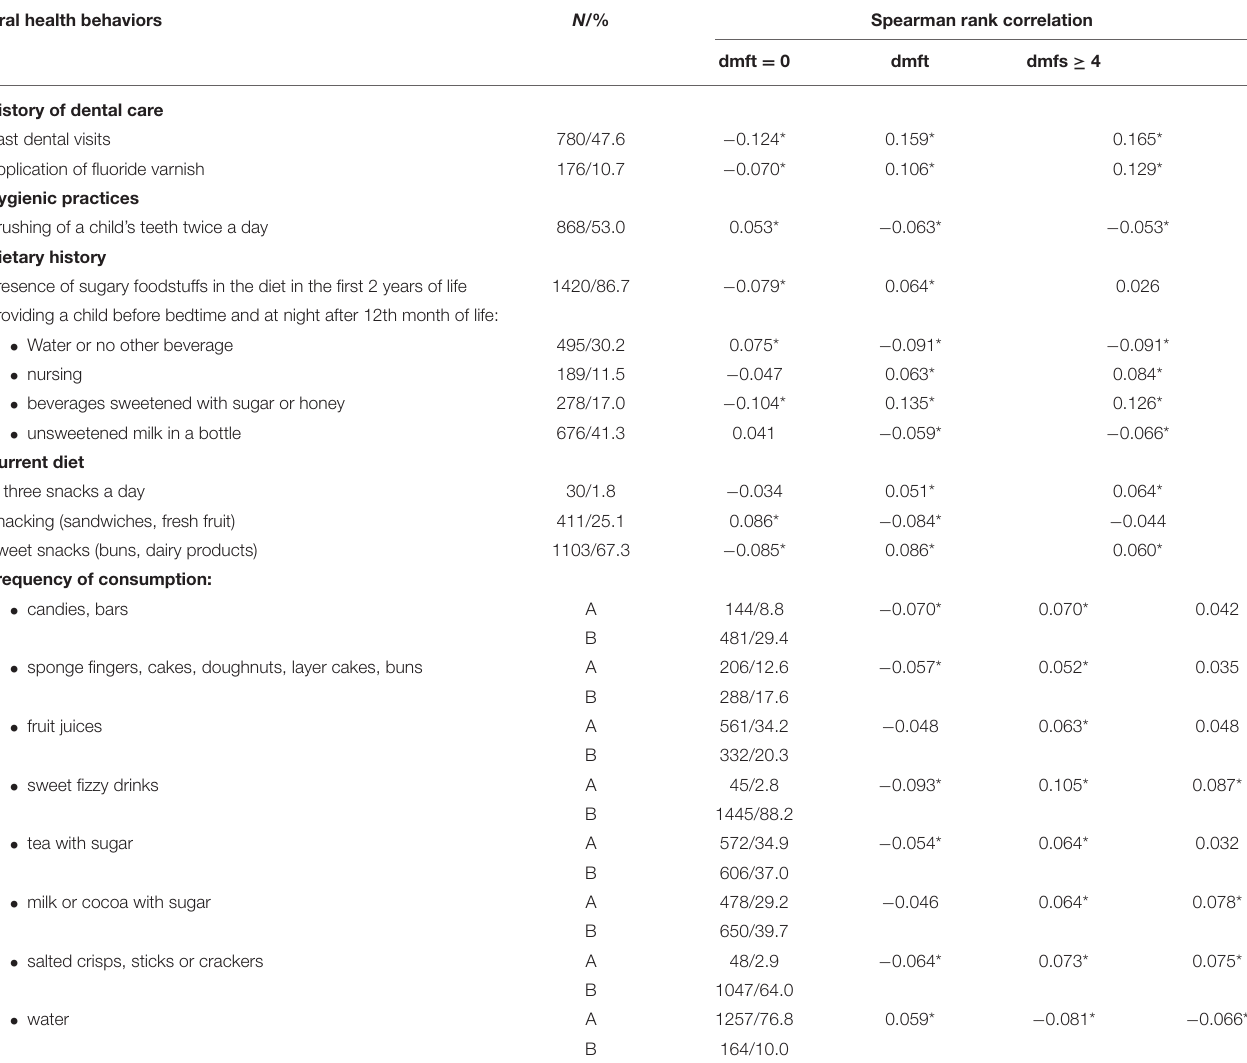
TABLE 1 | Oral health behaviors of children related to dental caries based on Spearman